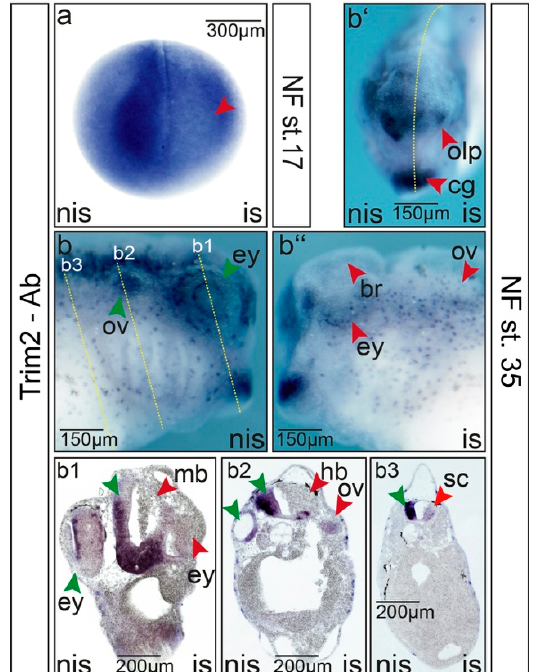
Figure 3. Suppression of trim2 function interferes with embryonic central nervous system (CNS) development. Microinjections of trim2 -morpholino were performed into one cell of a two-cell stage embryo. trim2 -morphants were analyzed by whole-mount immunochemistry using a commercial Trim2 antibody at ( a ) NF stage 17 and ( b ) NF stage 35. ( b ) Non-injected side (nis), (b‘) anterior view, (b‘‘) injected side (is). Forming brain (br), cement gland (cg), eye (ey), olfactory pit (olp), and otic vesicle (ov) showed loss of Trim2 expression. (b1–b3) Twenty-micrometer gelatine/albumin transverse sections of the cranial region. The embryonic brain appeared smaller and disorganized upon trim2 -morpholino injection. Midbrain (mb), eye (ey), hindbrain (hb), cement gland (cg), otic vesicle, and spinal cord (sc). Red arrowheads represent the affected region of the injected side. Green arrowheads indicate complementary regions of the control side (nis). Scales as indicated.